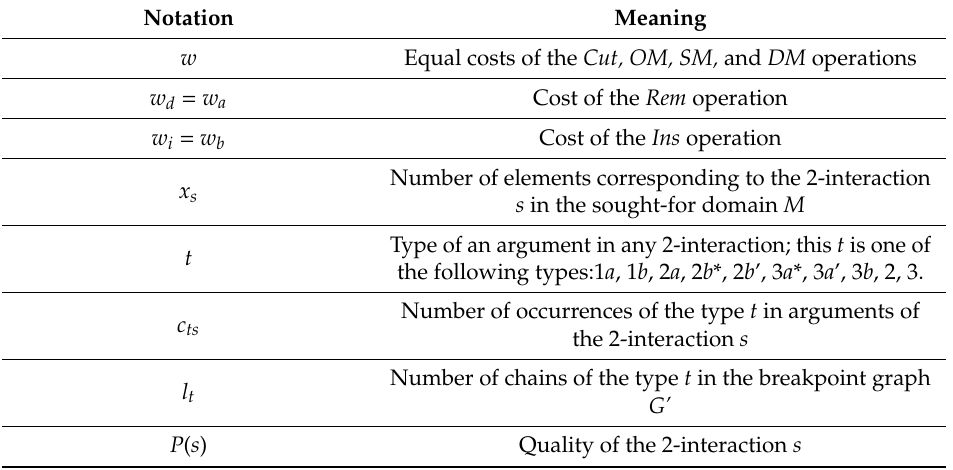
Table 1. Basic parameters predefined in or computed by the Algorithm for Case II. OM, single merging; SM, s esquialteral intermerging; DM, double intermerging.